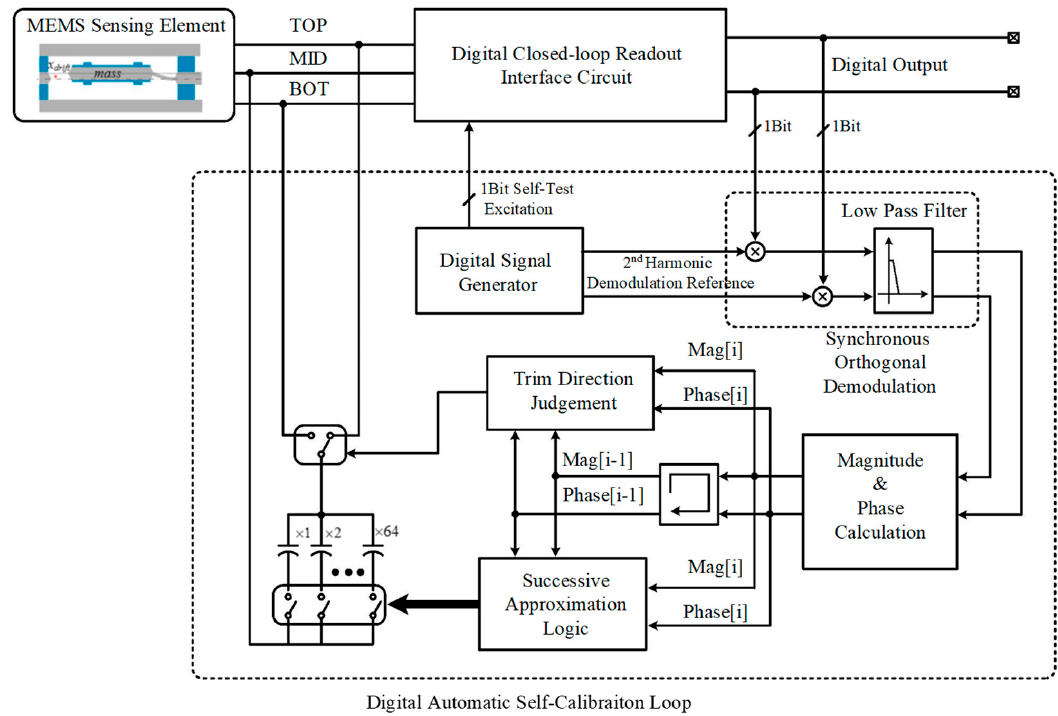
Figure 4. The diagram of the digital automatic self − calibration circuit.